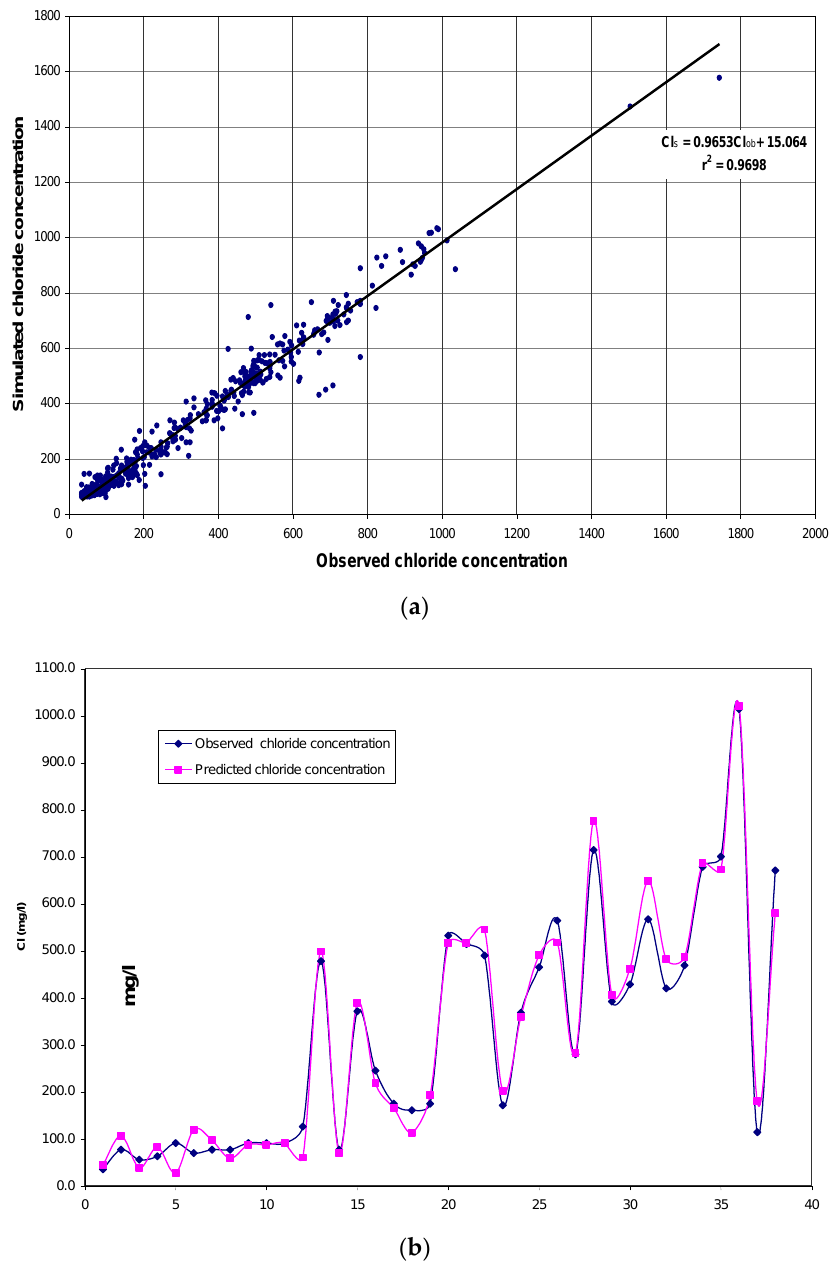
Table 3. The high value of the correlation coefficient (r) showed that the modelled chloride concentration values using the ANN model are in good agreement with the observed chloride concentration. While, the low value of the error mean, Abs E. mean, and S.D. ratio showed that the error between the observed and simulated chloride concentration values using the ANN model are small.